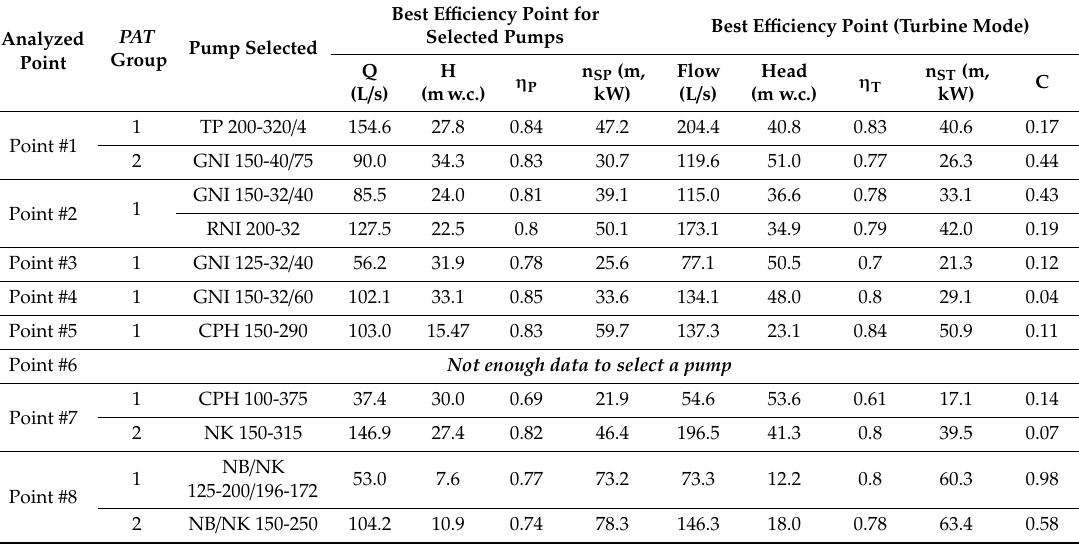
Table 15. Best e ffi ciency point (BEP) (pump and turbine mode) for the selected pumps from each point. Analyzed